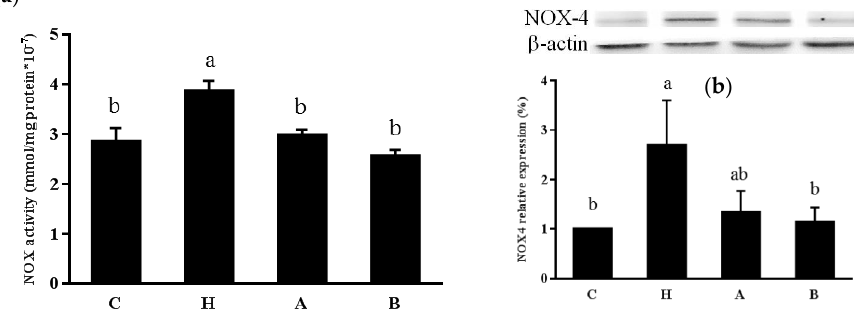
Figure 3. Kidney ( a ) NADPH oxidase (NOX) activity and ( b ) NOX4 protein expression in rats. Values are presented as the mean ± SEM ( n = 10). a b c Values with different superscript letters at the end of the study significantly differ ( p < 0.05). C, control group; H, hypertensive group; A, 20 mg/kg/day antroquinonol group; and B, 40 mg/kg/day antroquinonol group.